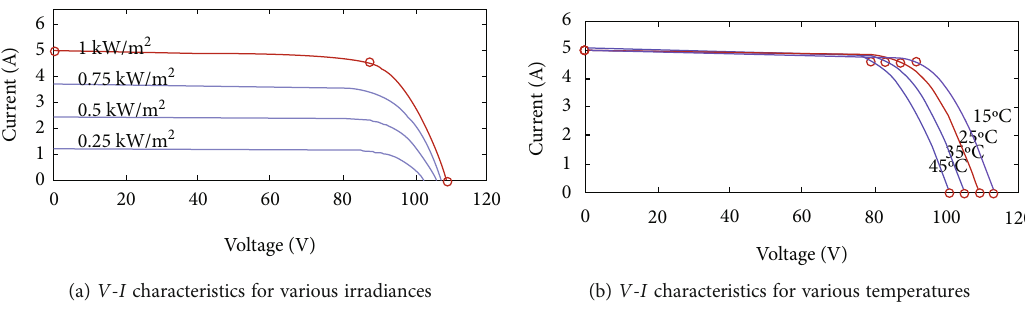
Figure 1: V - I characteristics of the PV array.